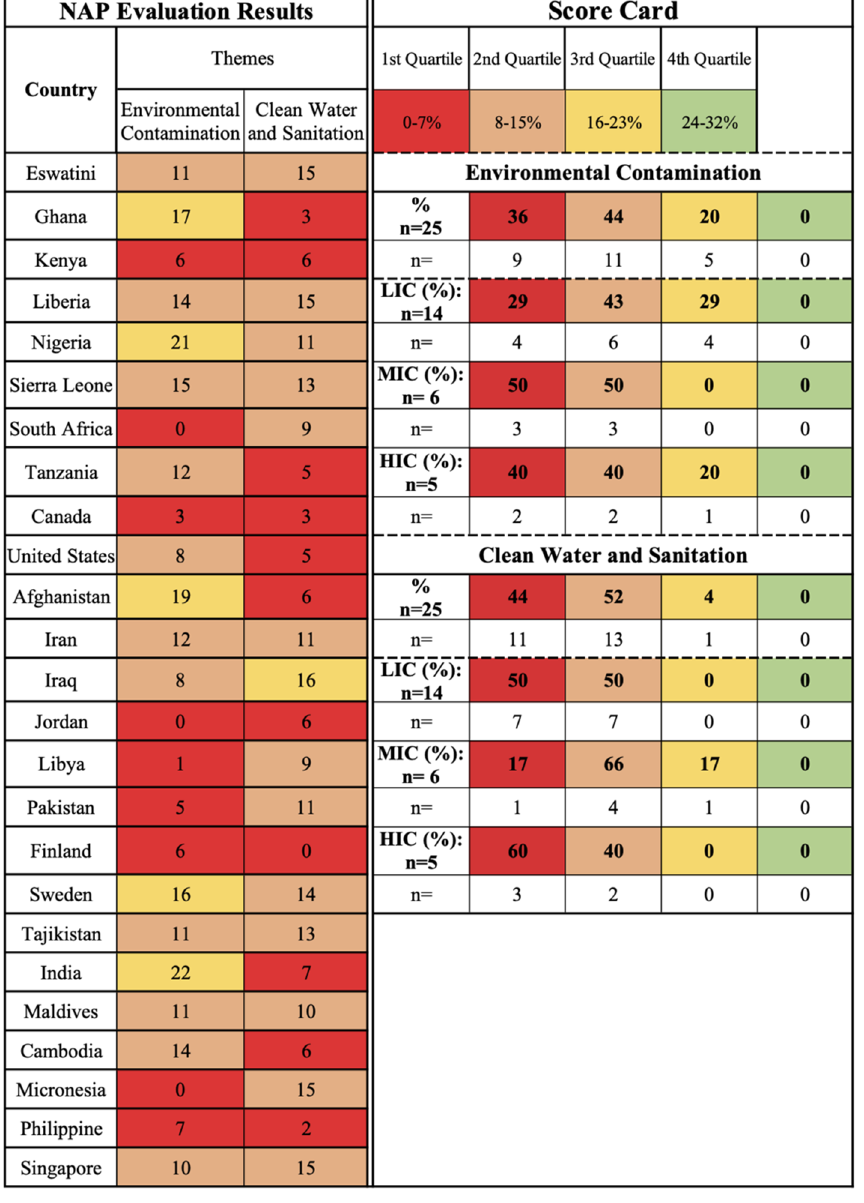
Figure 7. Environment sector themes (Environmental Contamination and Clean water and Sanitation) scorecard by country and income level.